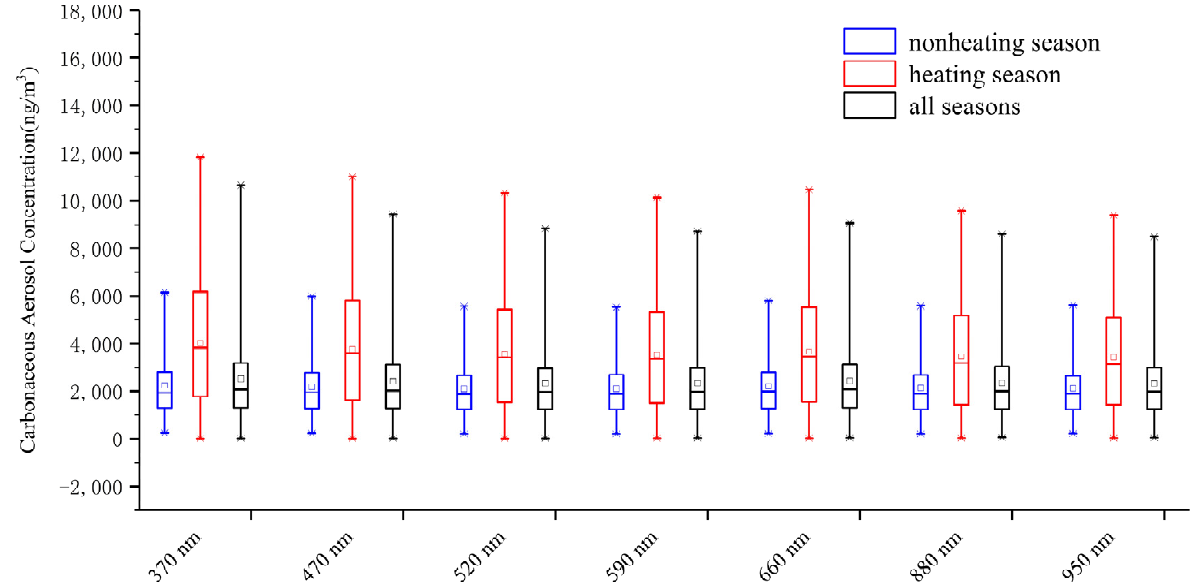
Figure 5. EBC concentrations in seven bands during the heating season, nonheating season, and entire year. The line in the box is the median mass concentration for each season. The upper and lower lines of the box represent the 1st and 3rd quartiles. The upper and lower whiskers represent values of 99% and 1%, respectively. The asterisks above the top line and below the bottom line are the maximum and minimum values.